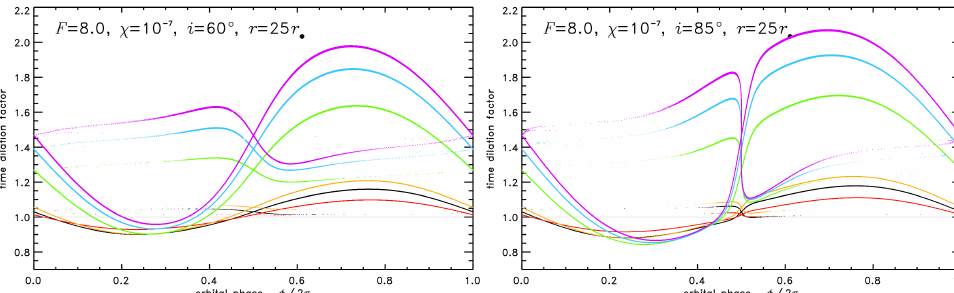
Figure 6. Time dilation factor of pulsed radiation from a pulsar located at different orbital phases. The black curve corresponds to the case that the pulsar orbits around a Schwarzschild black hole at a radial r = 25 M , and the colour curves corresponding to a mass distributions within the same orbital radius (see [69] for details). The viewing inclination angles are i = 65 ◦ ( left panel ) and i = 85 ◦ ( right panel